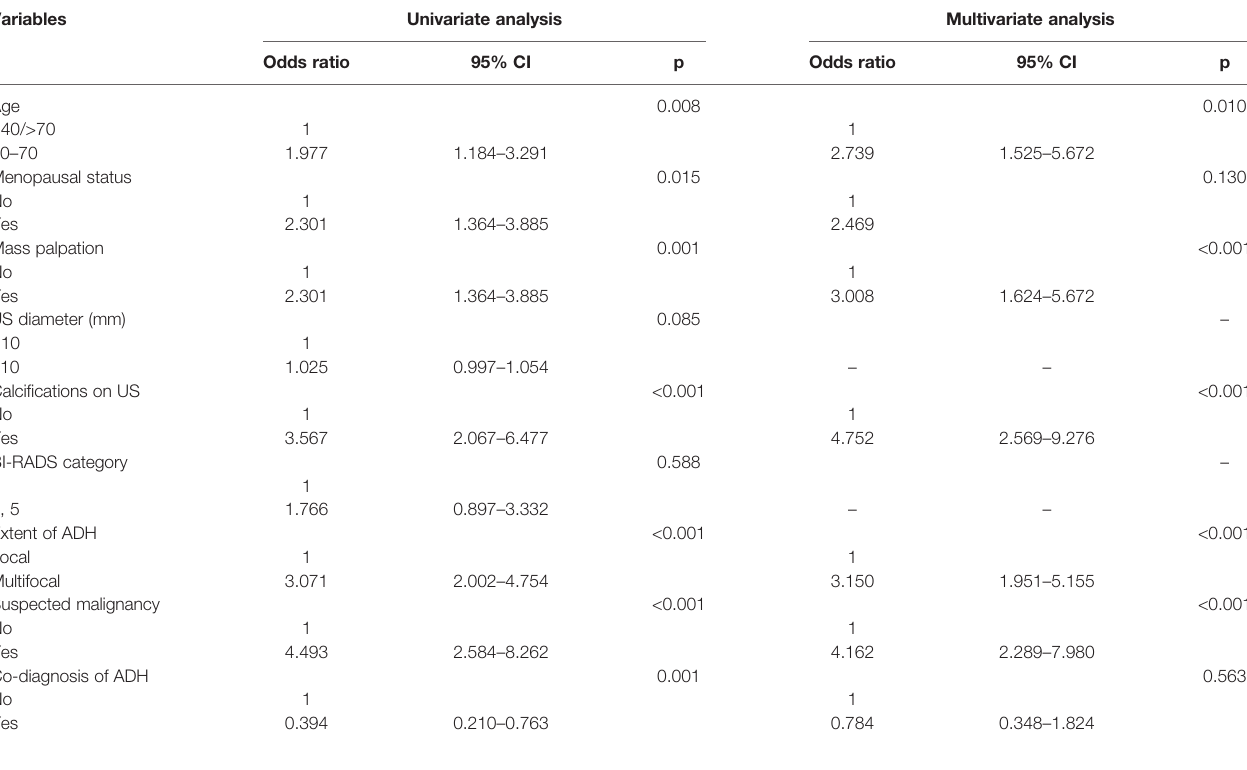
TABLE 2 | Univariate and multivariate logistic regression analyses of factors predictive of upgrading. Variables Univariate